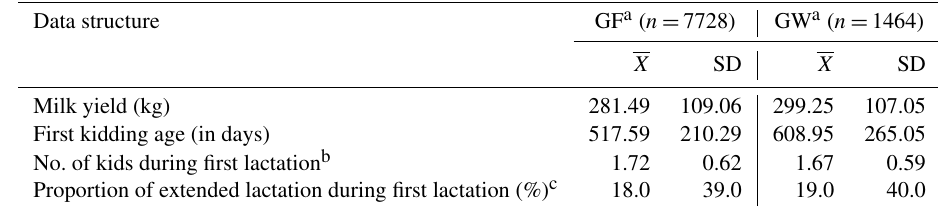
Table 3. Data structure of dairy goats during the first 120d of the first lactation. Data